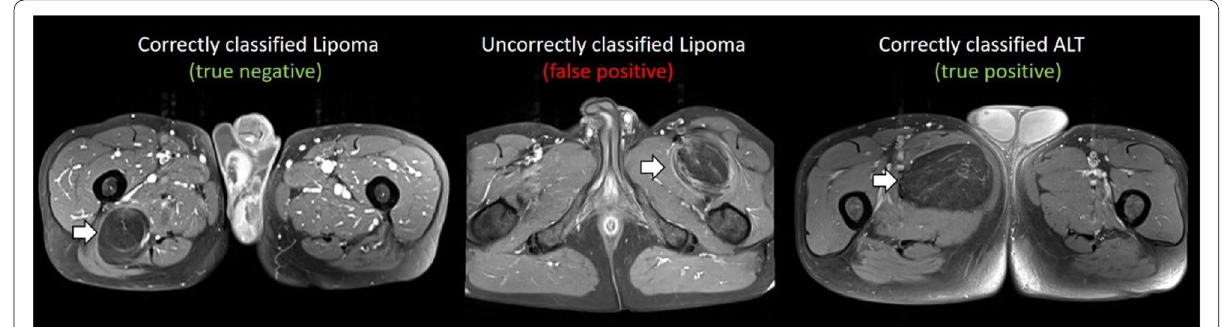
Fig. 3 Examples of true negative, false positive and true positive on external data given by the predictive model trained from ComBat‑harmonised radiomics features with the gradient boosting classifier